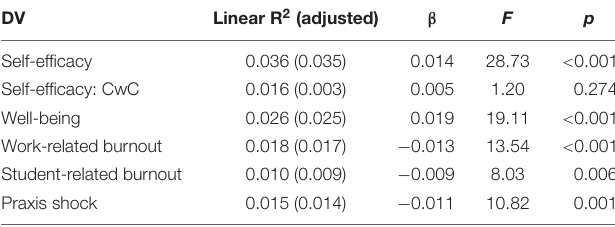
TABLE 3 | Change in psychological outcomes as a function of years teaching. DV